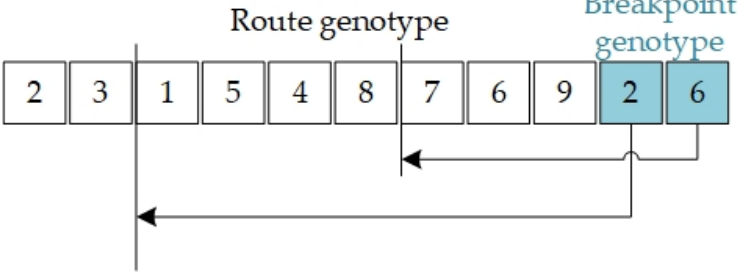
Figure 7. Example of individual genotype.